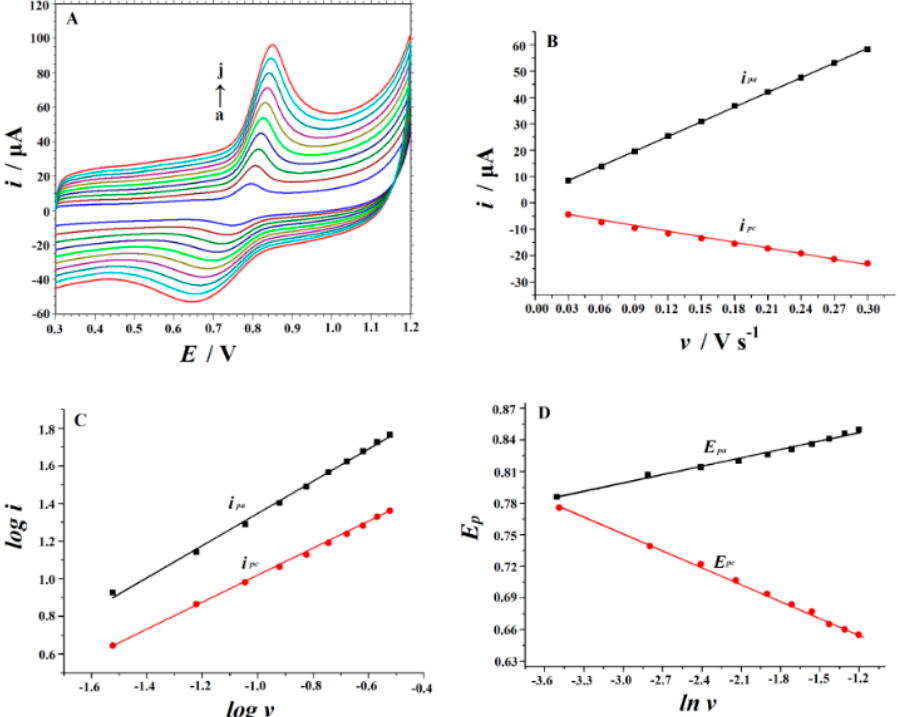
Figure 5. ( A ) Cyclic voltammograms of 10 µ M SY at MnO 2 NRs-ERGO/GCE with different scan rates. Curves (a–j) are obtained at 30, 60, 90, 120, 150, 180, 210, 240, 270 and 300 mV/s, respectively. ( B ) The plot for the dependence of peak current on scan rate. ( C ) The relationship between log i p and log v . ( D ) The relationship between E p and ln v .